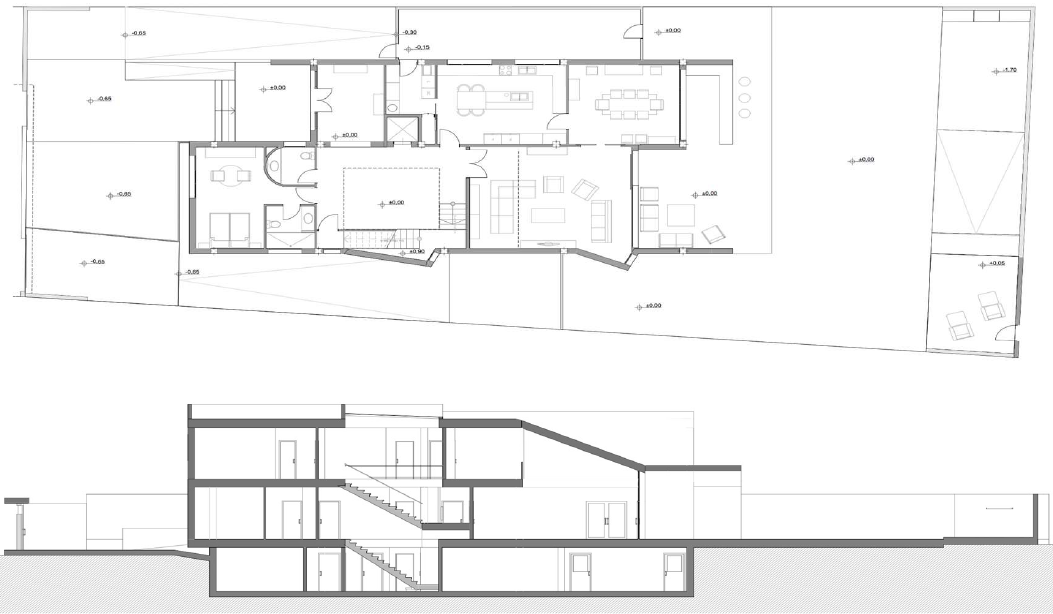
Figure 8. Ground floor and longitudinal section of Casa Zaranda.